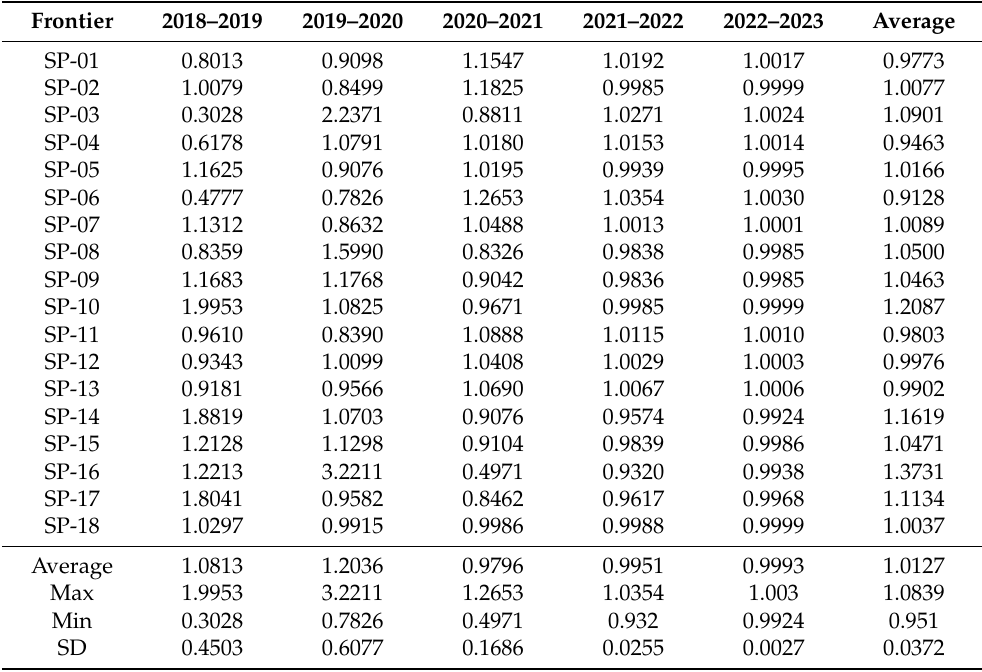
Table 7. Technical efficiency changes for the period